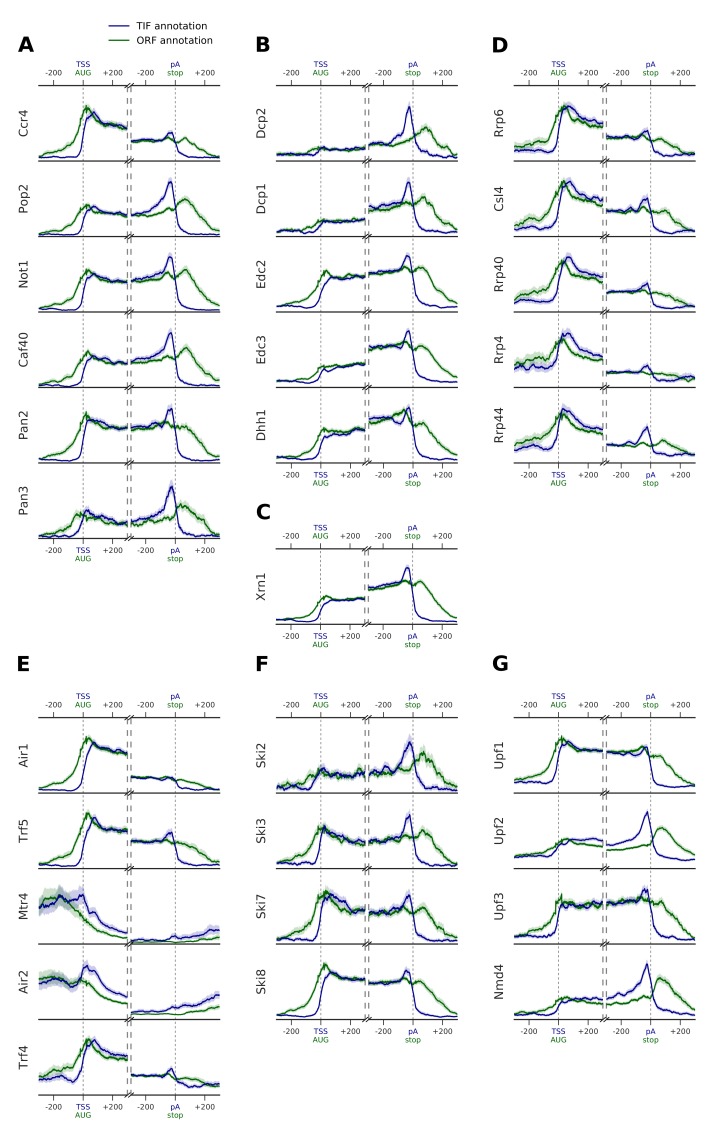
Metagene profiles of yeast RNA degradation factors centered on translation start and stop sites in comparison to TIF-annotated TSS and pA sites.Transcript-averaged PAR-CLIP occupancy profiles are shown for RNA degradation factors involved in (A) deadenylation, (B) decapping, (C) 5´→3´ exonuclease Xrn1, (D) exosome, (E) TRAMP, (F) Ski, and (G) NMD. Transcripts are aligned either at transcript start site (TSS) and poly-adenylation (pA) site (marked with blue) or at their start and stop codons (marked with green). TIF-seq based annotation is shown in blue (n = 3193 for TSS and pA site profiles) (Pelechano et al., 2013). Open reading frames (ORF) annotated in the SGD (version 64.2.1) are shown in green (n = 4012 for TSS, and n = 3965 for pA site selected transcripts). To avoid contaminating signals from neighboring genes, we filtered out regions that had annotations upstream and downstream of the centered gene (up to 700 nt) (Materials and methods). Shaded areas (in blue TIF-seq annotation, or in green for ORF annotation) depict 95% confidence intervals derived from bootstrapping genes. Comparison between these two profiles highlights preferences for end binding degradation factors in binding to untranslated regions at the two sides of the transcript.